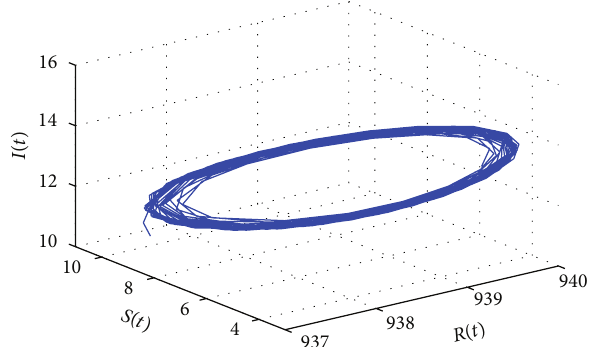
Figure 5: The phase plot of the states 𝑆 , 𝐼 , and 𝑅 for 𝜏 = 1.3625 > 1.3265 = 𝜏 0 .